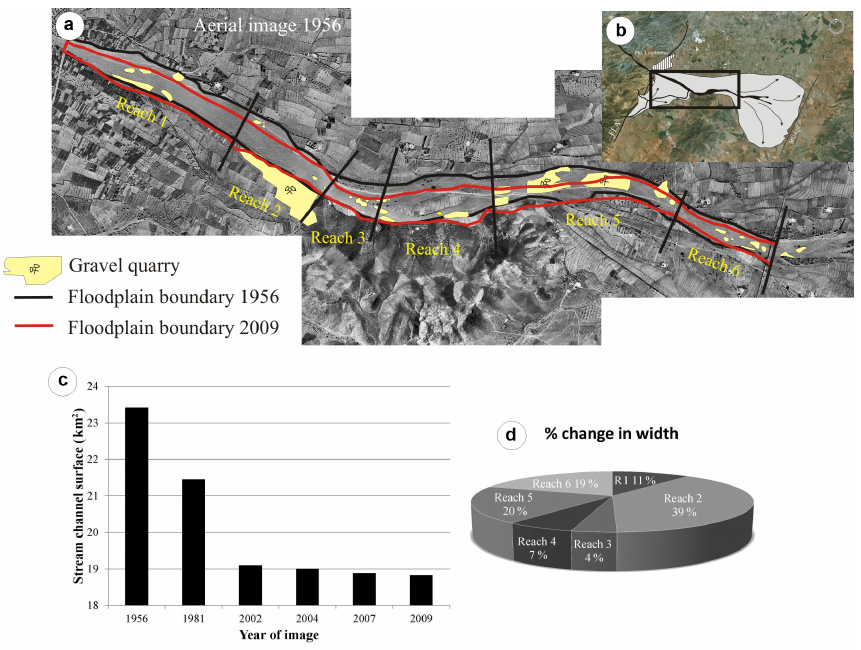
Figure 4. (a–b) Location of the studied channel reaches and entrenchments showing channel bank boundaries change between 1956 and 2009 and related gravel quarries. (c) Recent evolution in stream channel area. (d) Percentage of channel width change for each reach.